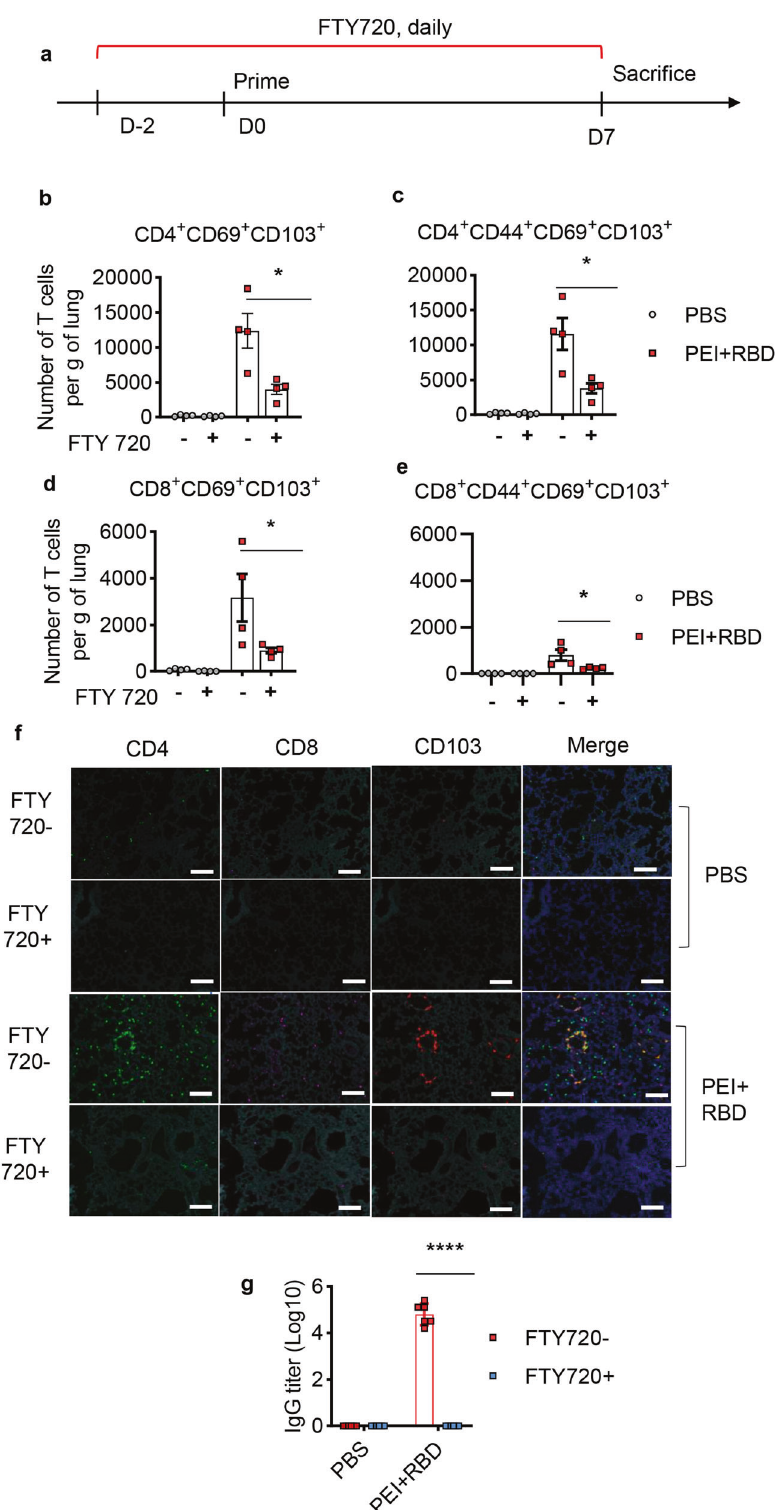
Fig. 6 Lung T-cell responses result from T-cell migration into lungs after prime immunization with the intranasal RBD vaccine. C57BL/6 mice were primed with PBS or PEI-adjuvanted RBD vaccine in the presence or absence of FTY720 treatment. On day 7, immunized mice were sacri fi ced. Lung tissues and serum samples were collected for the analysis of lung T-cell responses and serum IgG levels, respectively. a Schedule of vaccine delivery in the presence of FTY720 during prime immunization. Quanti fi cation of lung CD4 + ( b ), CD4 + CD44 + ( c ), CD8 + ( d ), and CD8 + CD44 + ( e ) T cells that highly express both CD69 and CD103 after prime. f Immuno fl uorescence analysis of lung CD4 + and CD8 + T cells with elevated CD103 expression in immunized mice on 3dpi. Green, CD4; violet, CD8; red, CD103; blue, DAPI. Scale bar, 100 μ m. g RBD- speci fi c IgG titers in the serum after prime in the presence or absence of FTY720 were assessed with ELISA. All the data were presented as mean ± SEM. n = 4 – 5. P values were compared to PBS group (* P < 0.05; **** P < 0.0001) Signal Transduction and Targeted Therapy (2022)